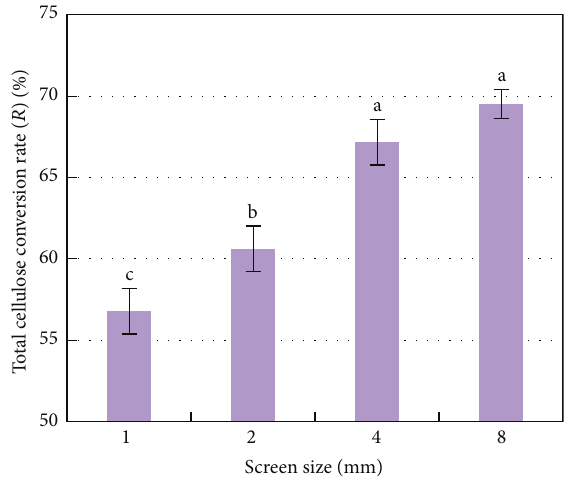
Figure 12: Effects of screen size on total cellulose conversion rate.